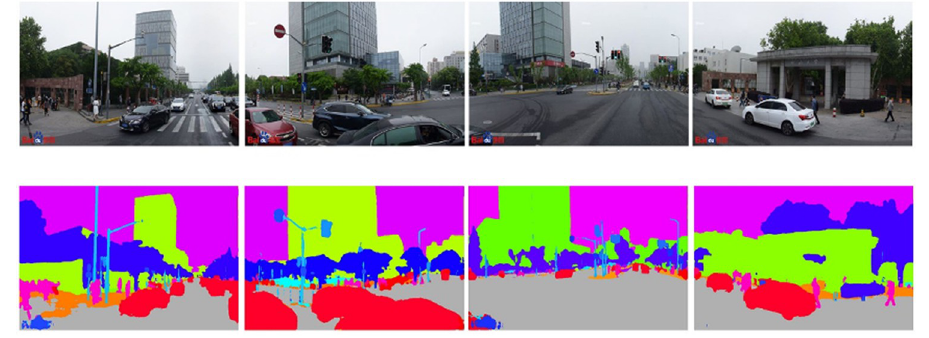
Fig 3. Semantic segmentation results of SVPs.